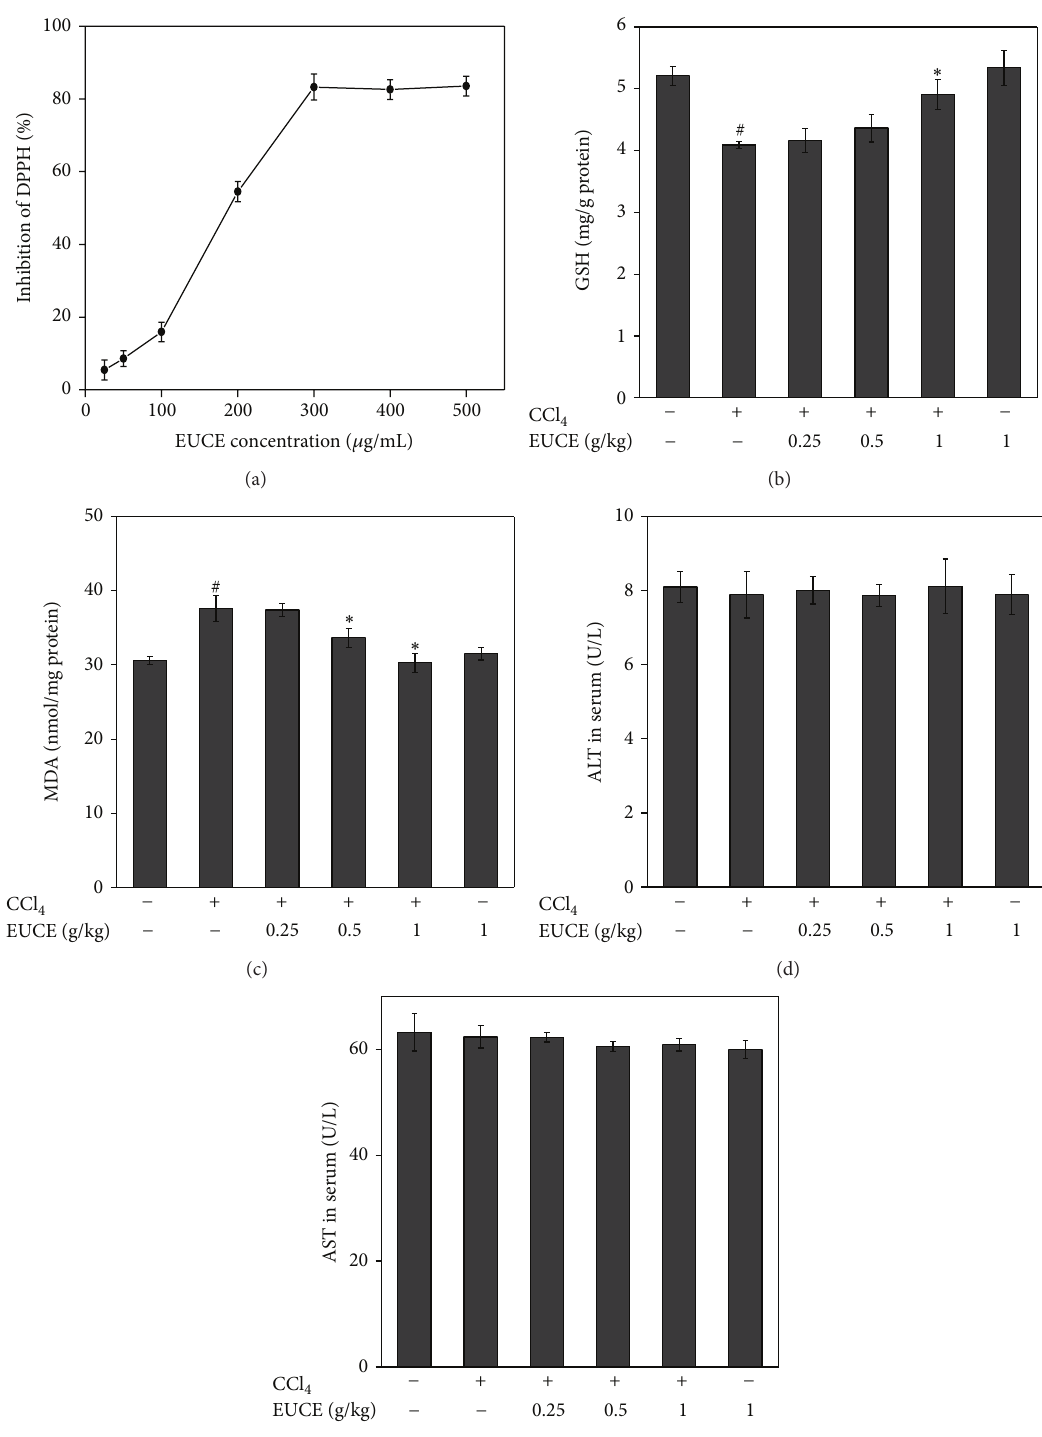
Figure 3: Effect of EUCE on free radical scavenging activity and CCl 4 -induced increases in liver glutathione (GSH) and malondialdehyde (MDA). A difference was found in ALT and AST levels after injection of CCl 4 . Values are mean ± SD, 𝑛 = 8 . Asterisks indicate differences from the group treated with CCl 4 only ( ∗ 𝑃 < 0.05 ). # 𝑃 < 0.05 indicates a significant difference compared with the control